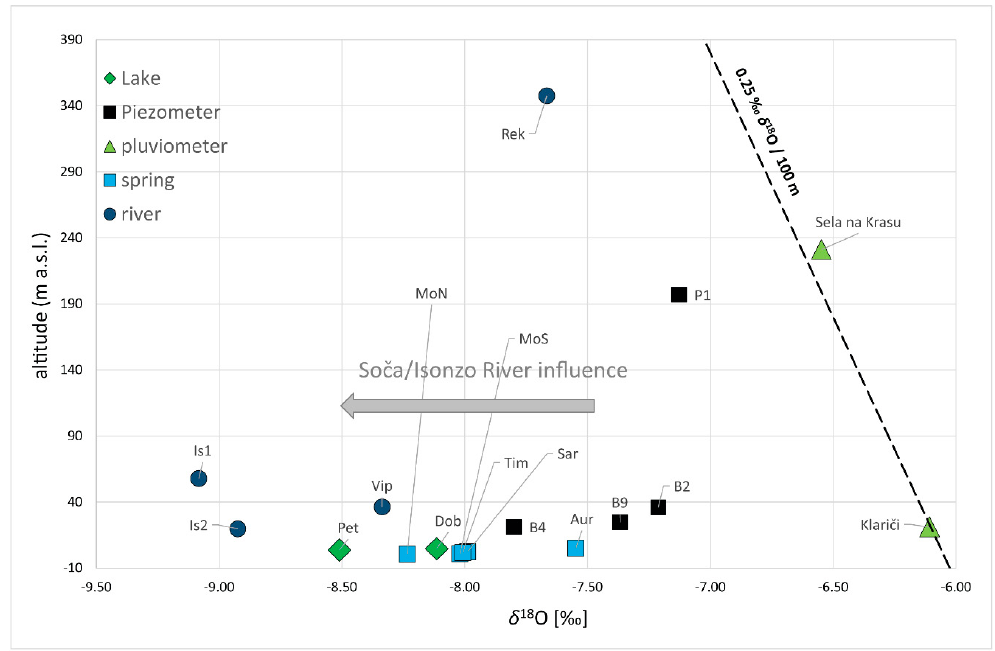
Figure 5. Isotopic composition of mean δ 18 O versus the altitude of the sampling locations. The two green triangles represent the precipitations data collected in correspondence of Klari č i and Sela na Krasu pluviometers. The obtained isotopic gradient is in accordance with the values of Michelini [78] of − 0.22‰ δ 18 O/100 m and Mezga et al. [79] of − 0.25‰ δ 18 O/100m. Analyzing the data of δ 18 O versus δ 2 H, during different hydrogeological regimes (Figure 6a— low flow, 6b—high flood and 6c—moderate flood) different behaviors emerge. The water from piezometers B2, B9 and P1 is always enriched in 18 O (less negative values), close to the ones characteristics of the local precipitations (Klari č i mean δ 18 O is − 6.11‰ and Sela na Krasu mean δ 18 O − 6.53‰). It can be affirmed that the piezometers represent the right end ‐ member of the mixing line. The other end ‐ member is defined by the So č a/Isonzo River (Is1 and Is2) sampled waters, which are instead always more depleted (more negative values) than all the other values.